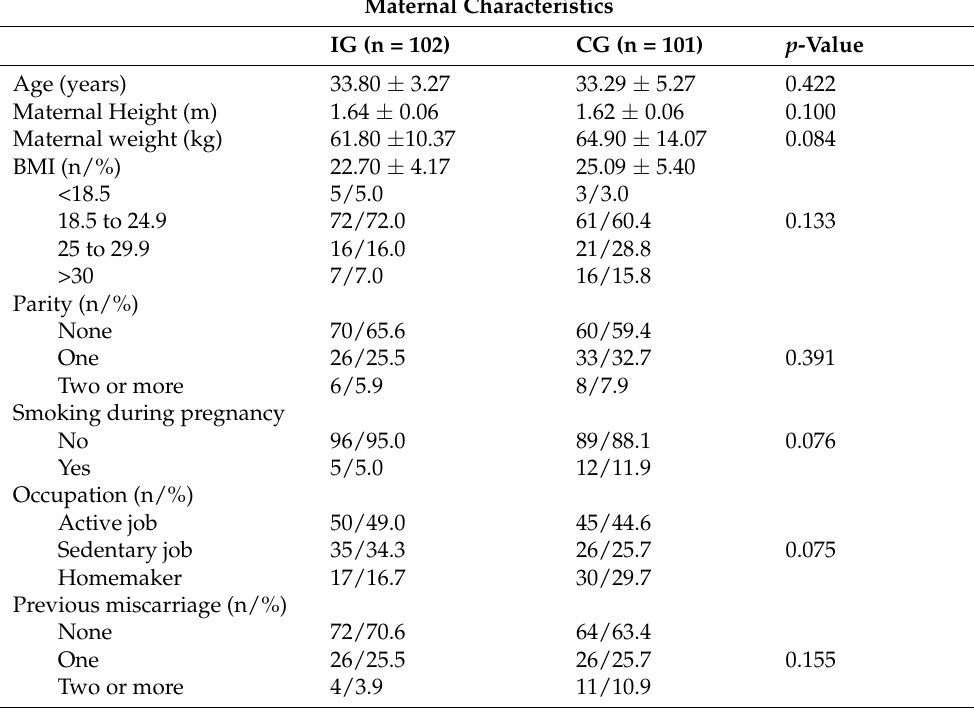
Table 1. Maternal characteristics at baseline.